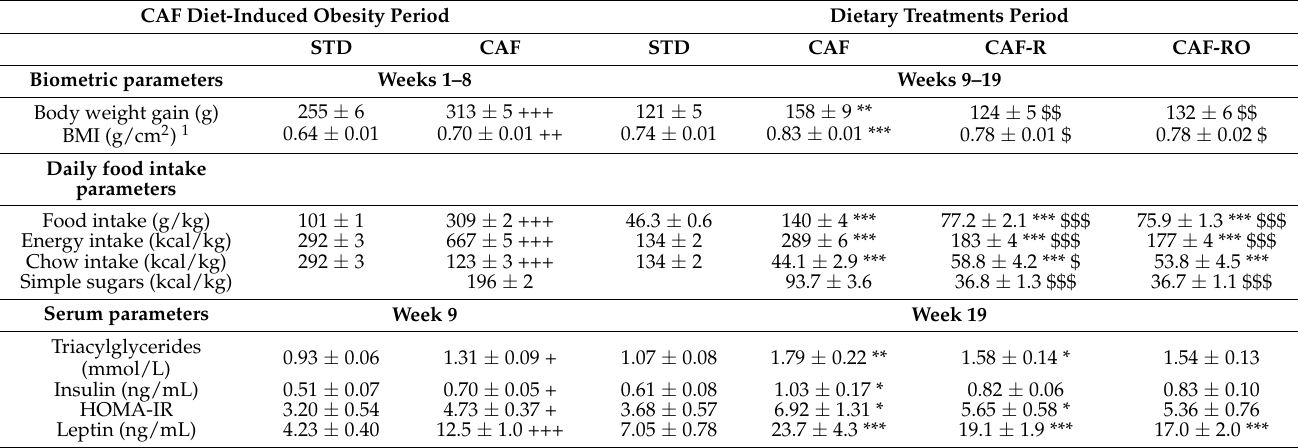
Table 1. Biometric, food intake and serum